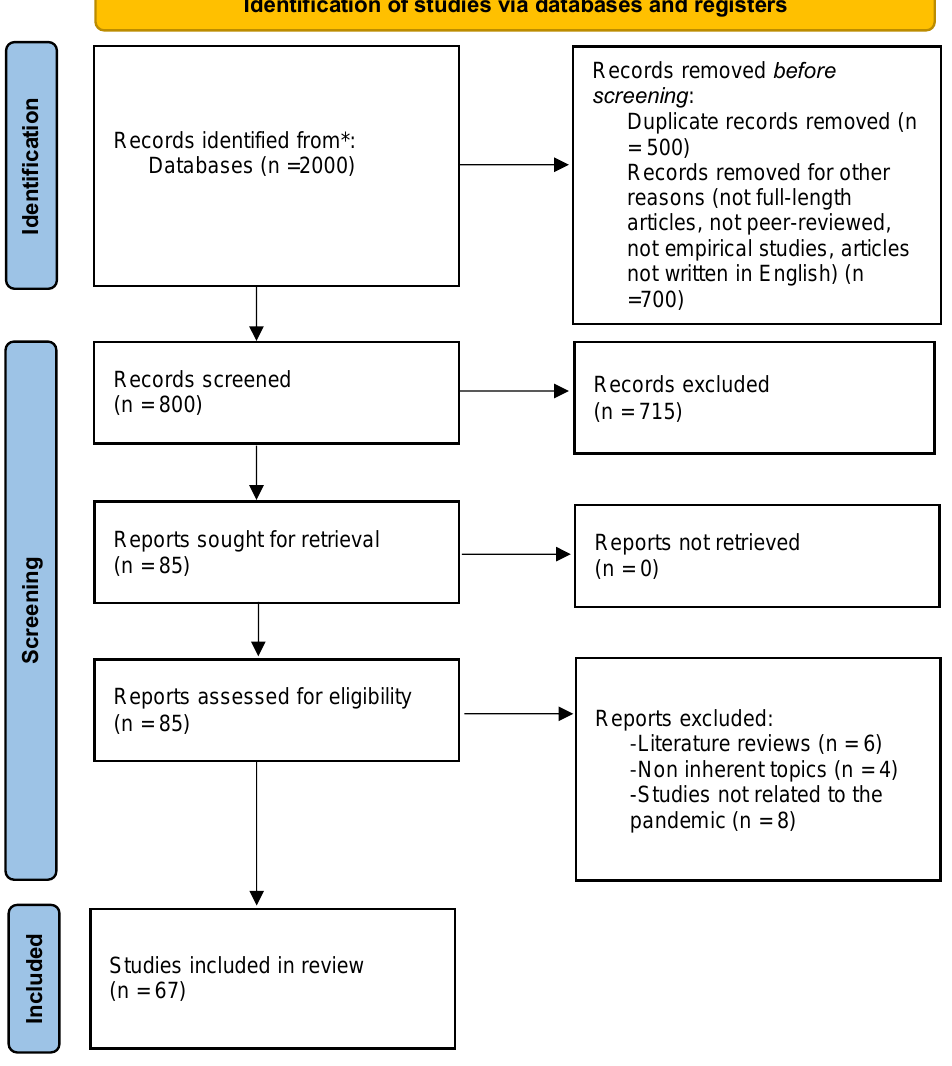
Figure 1. Study selection workflow.